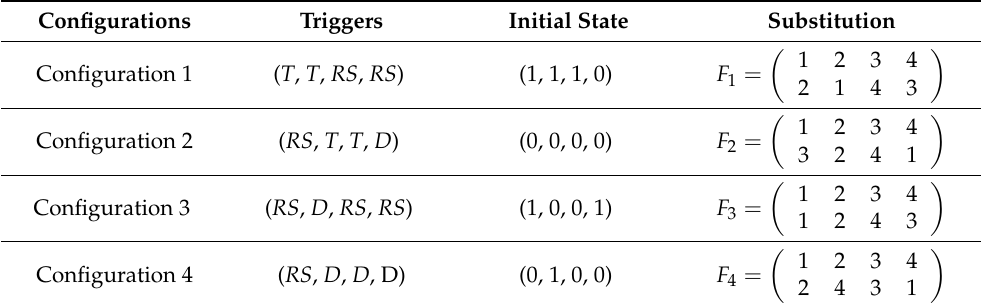
Table 1. Example of an initial population. Configurations